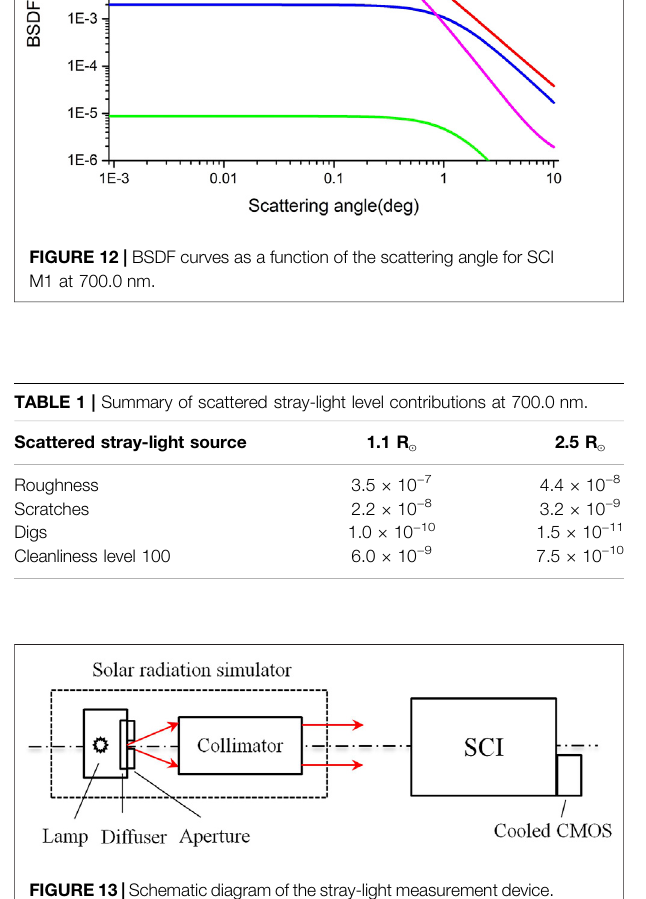
FIGURE13 | Schematic diagram ofthe stray-light